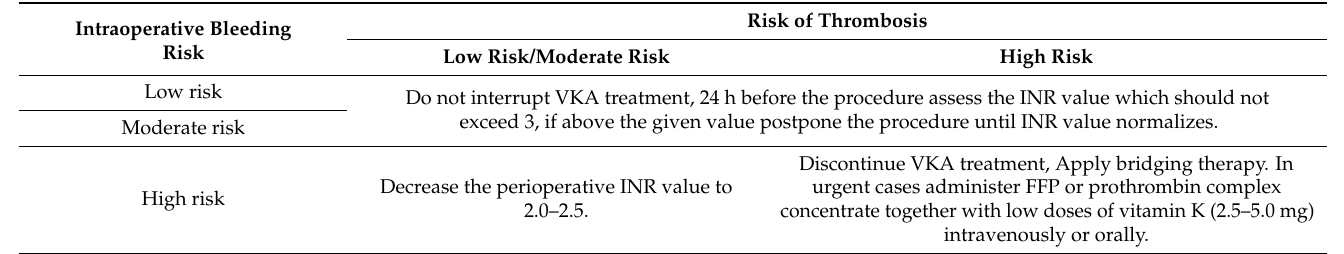
Table 3. The table shows the management regimen for patients receiving Vitamin K antagonists